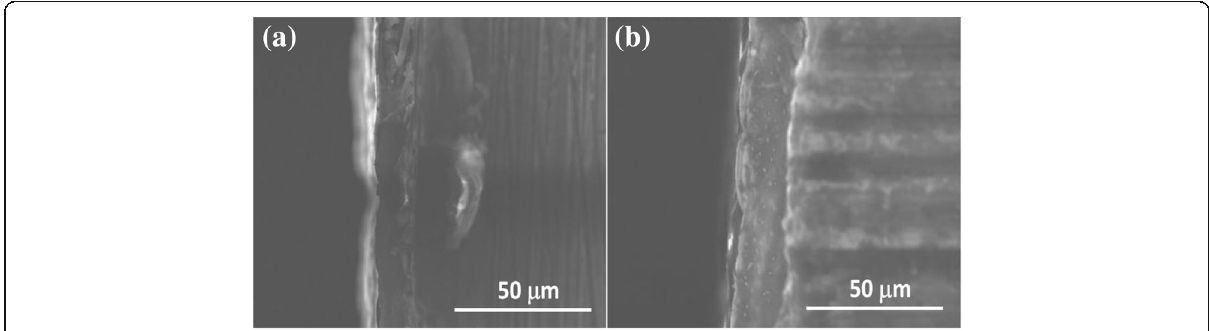
Fig. 6 Cross-section morphology images of the Ni-P coating ( a ) and Ni-P-Al 2 O 3 (3.6 wt%) composite coatings ( b